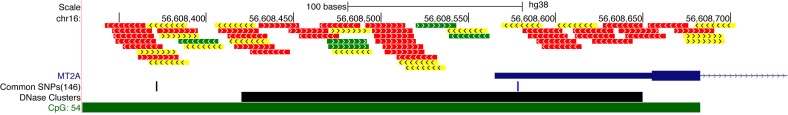
CHOPCHOP results can be exported to the UCSC browser with a single click. Here, the sgRNAs (in this example in promoter-targeting mode) are viewed in the context of the genome. The tracks displayed in this example are DNase sensitive regions, common SNPs and CpG islands.